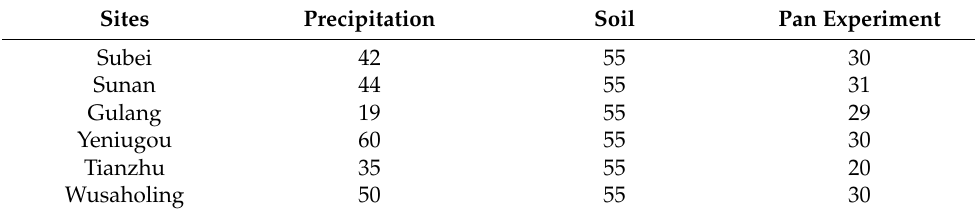
Table 3. Inventory of sample numbers collected at the Qilian